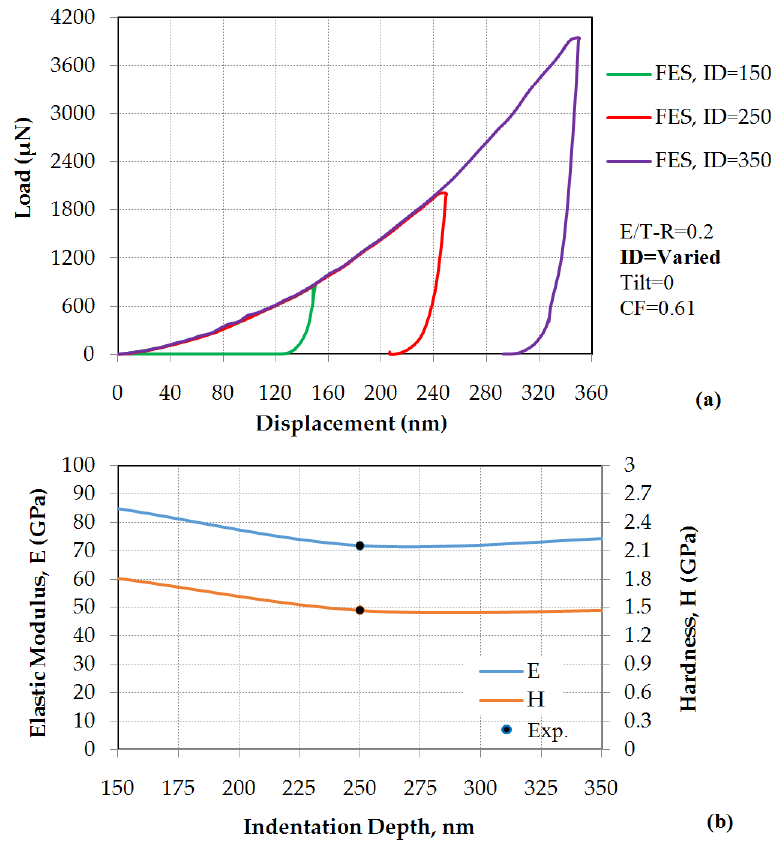
Figure 11. ( a ) Load/unload-displacement curves, and ( b ) variation of the elastic modulus and hardness in nanoindentation experiments of aluminum 1100 with different indentation depths.